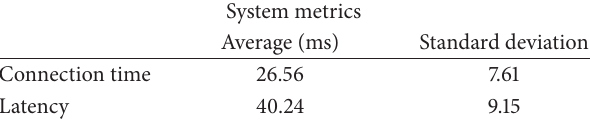
Figure 16: MST versus message length. Table 5: Latency and connection